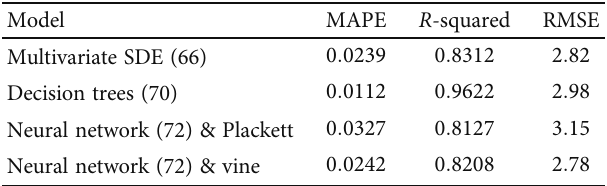
Table 6: Precision metrics for